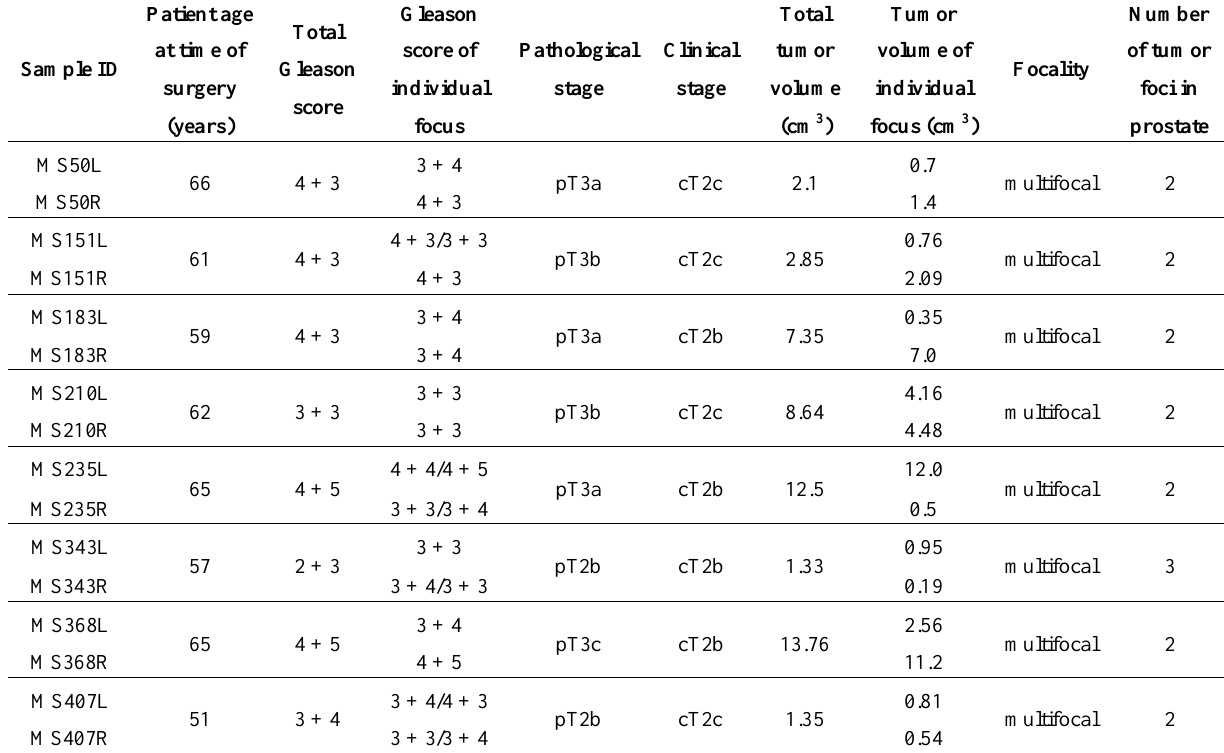
Table 1. Clinical and pathological information of investigated